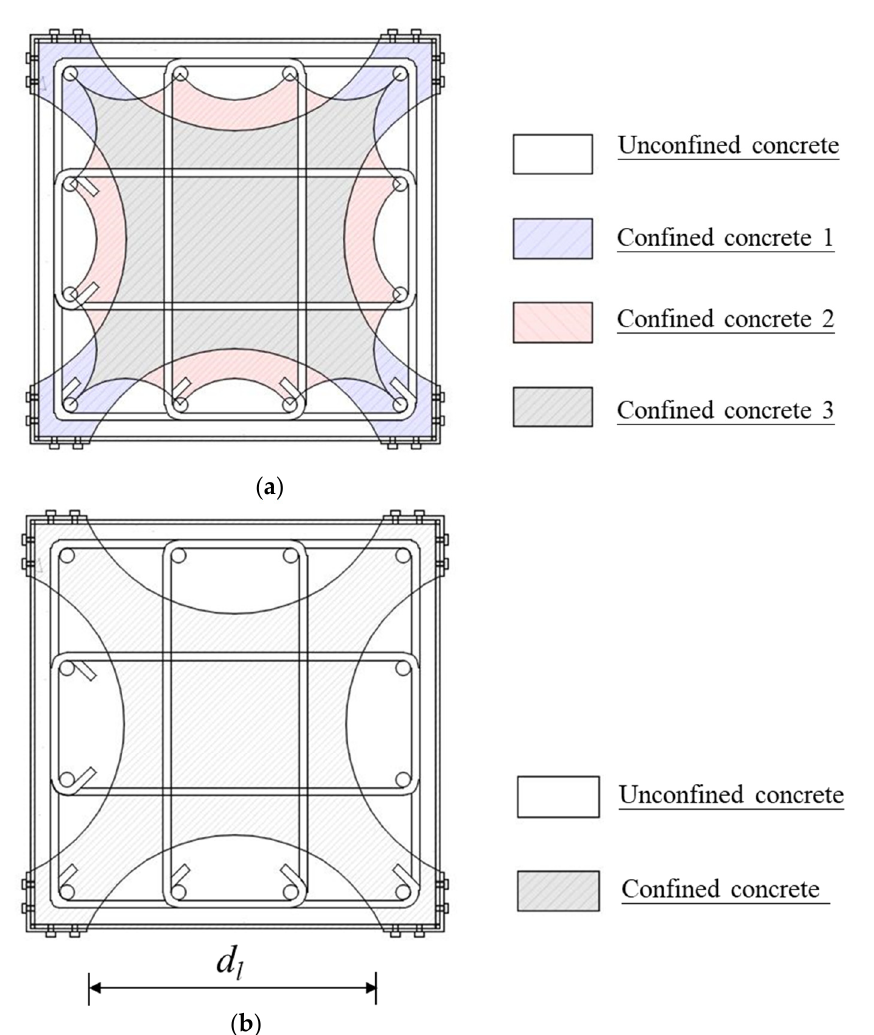
Figure 8. Divisions of the confined concrete: ( a ) exact divisions; ( b ) simplified divisions.